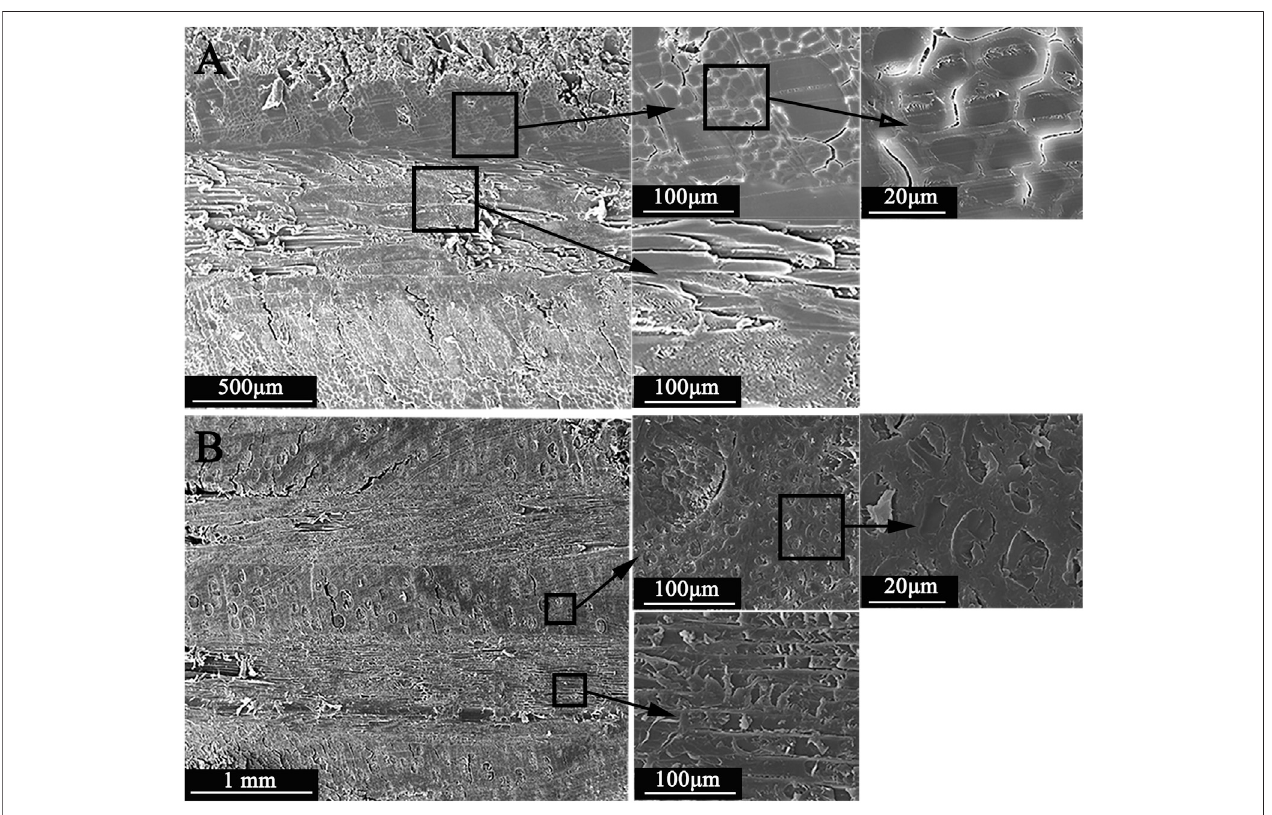
FIGURE 6 | SEM image of multilayer transparent wood ( A .TW-3; B